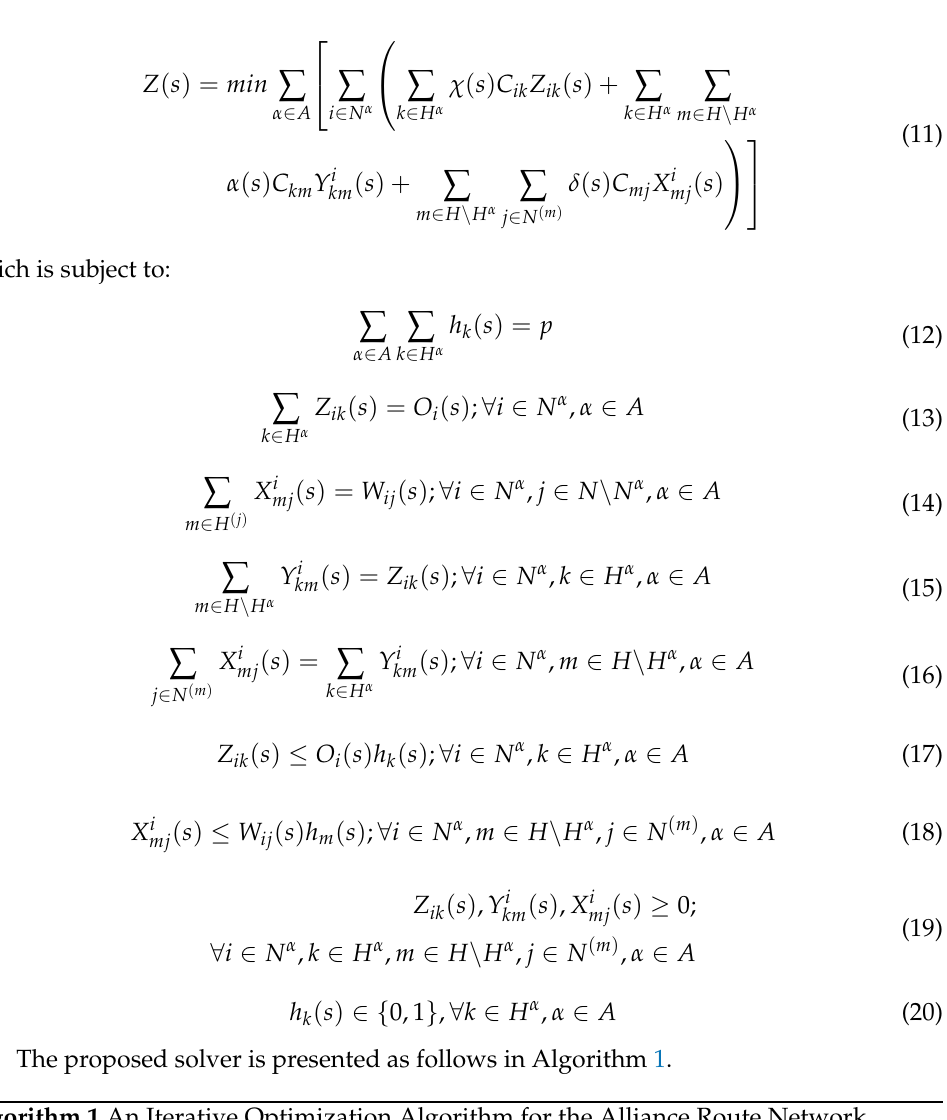
Algorithm 1 An Iterative Optimization Algorithm for the Alliance Route